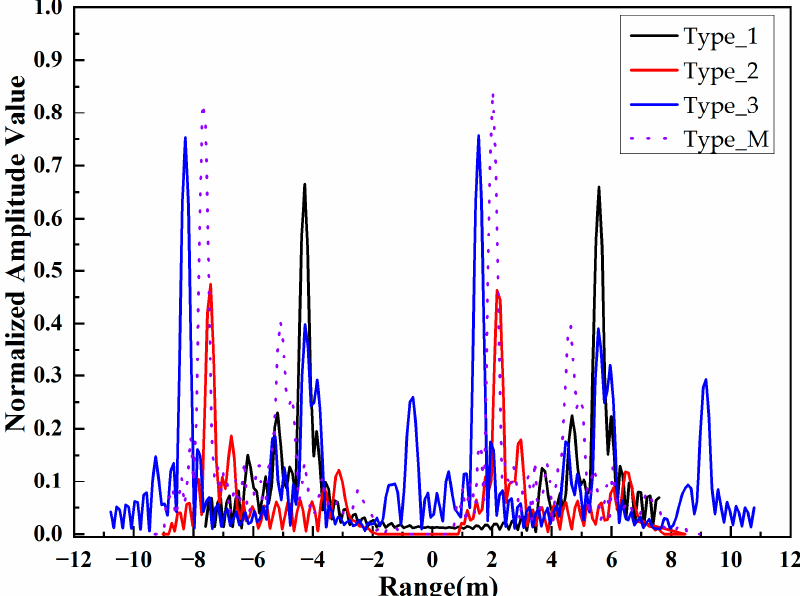
Figure 16. The HRRP of di ff erent types of hybrid dielectric and conductor missile-like targets in the free space.